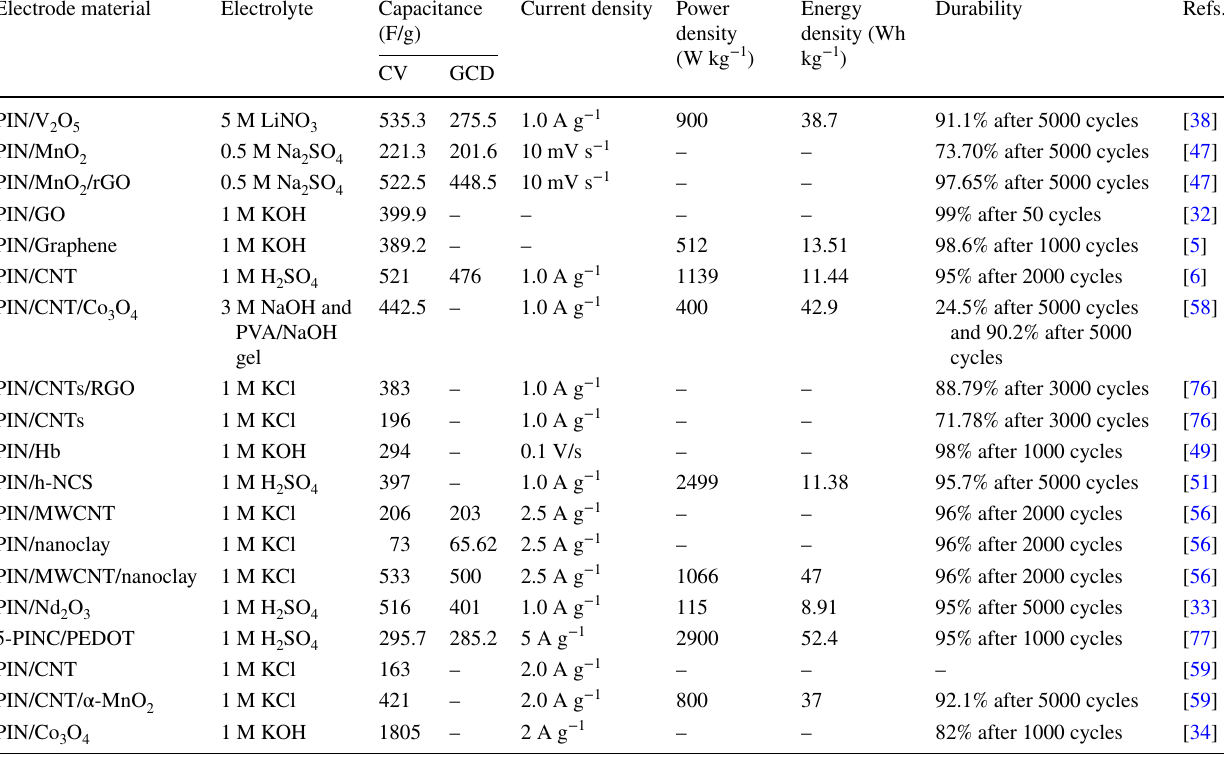
Table 3 A tabular comparison of PIN composites reported for supercapacitor application Electrode